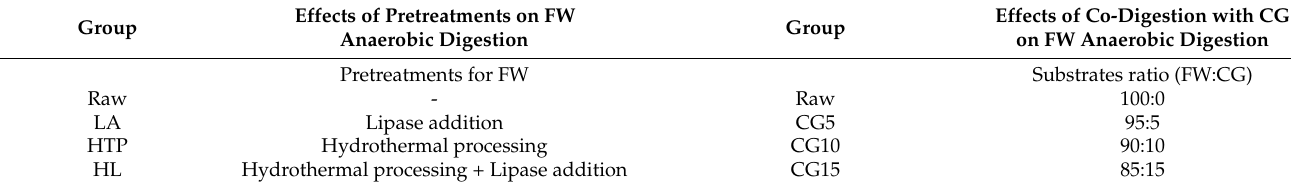
Table 3. Fermentation substrates used as feed for different experimental